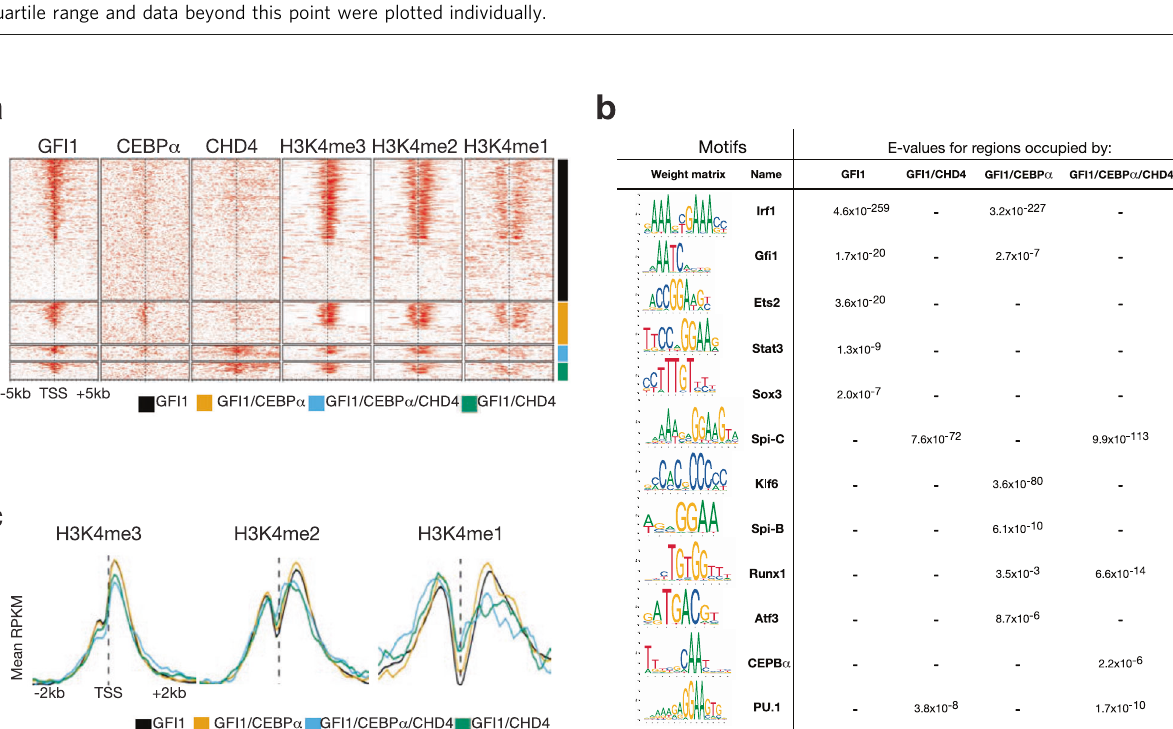
Fig. 4 GFI1 and GFI1/CHD4 occupy actively transcribed regions. a Heatmap of ATAC-seq and ChIP-seq analyses were obtained with antibodies against GFI1, CHD4, and methylated and acetylated histone H3 from GMPs. Shown are reads for promoter regions with 5 kb 5 ′ and 3 ′ of TSS ordered according to CHD4 occupation and were separated into three groups: occupation by CHD4 alone, by GFI1 and CHD4, and by GFI1 alone. (TSS transcription start site). b Aggregation plots for promoters occupied by GFI1, CHD4, and methylated and acetylated histone H3 with the data shown in ( a ). Shown is the fold enrichment over a region of 2 kb 3 ′ and 5 ′ of the TSS. (TSS transcription start site). The differences in epigenetic marks for regions bound by CHD4 and or GFI1 in ( b ) and ( d ) (see below) are due to background signals since in some cases reads are counted which do not necessarily represent sites because cut off parameters were kept identical throughout the experiment. The signal in ( b ) and ( d ) represent the intensity of the reads that were mapped in the selected regions. To ensure all regions are compared between samples, the same parameters were used for the peak calling step in the same category. c Exemplary depiction of the ATAC-Seq and ChIP-Seq data at the GFI1 target gene Csf1 . Indicated are the tracks corresponding to the individual experiments, the gene, and the TSS. Annotations represent locations on the mouse genome version GRCm38 (mm10). d Aggregation plots for enhancers occupied by GFI1, CHD4, and methylated and acetylated histone H3. Shown is the fold enrichment over a region of 2 kb 3 ′ and 5 ′ of the TSS (transcription